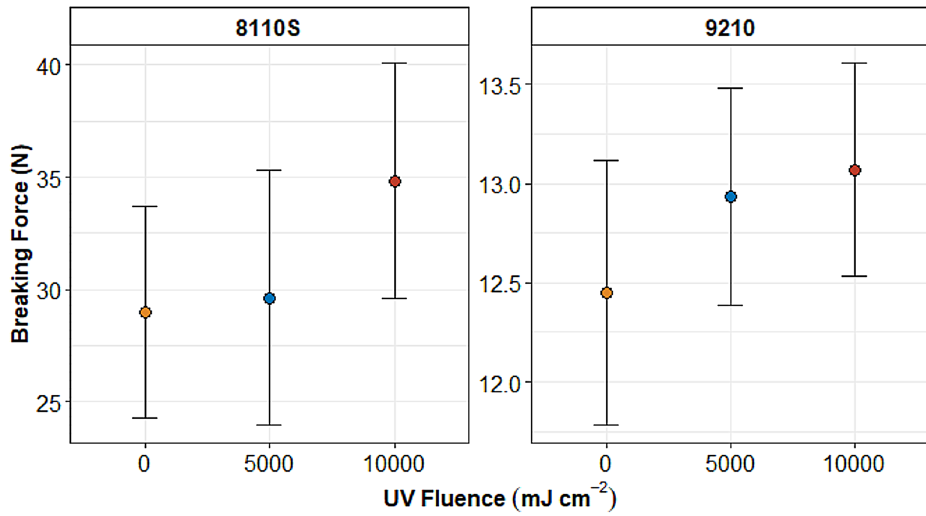
Figure 3. Breaking force vs UV fluence from 8110S and 9210 N95 respirator straps. Error bars represent one standard